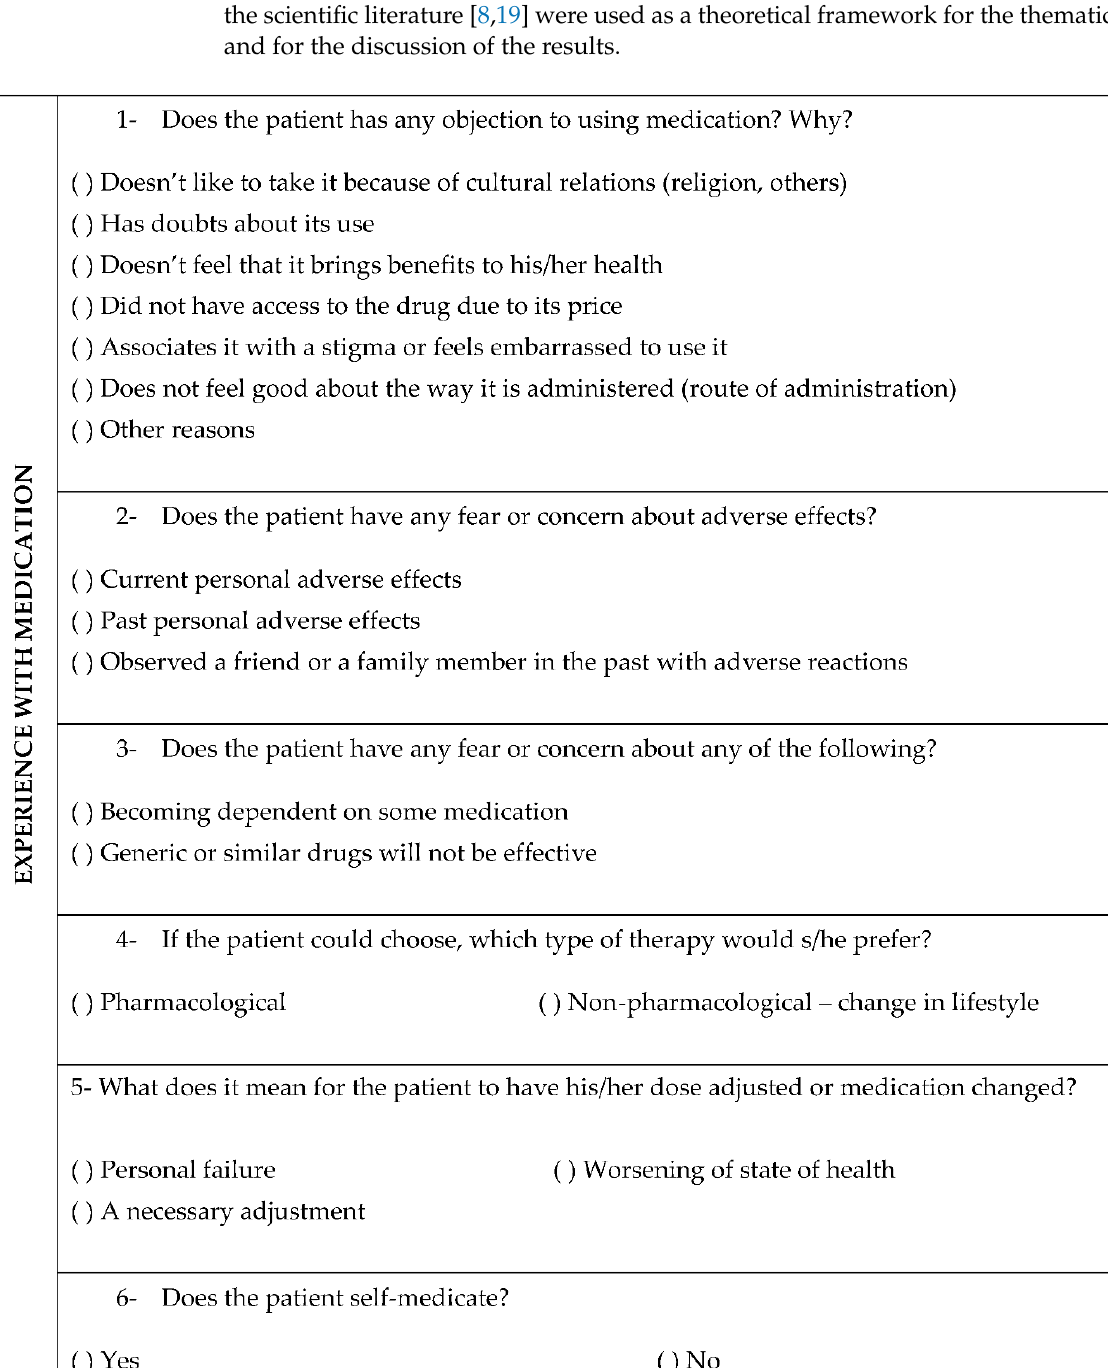
Figure 1. Instrument used to collect subjective patient data.